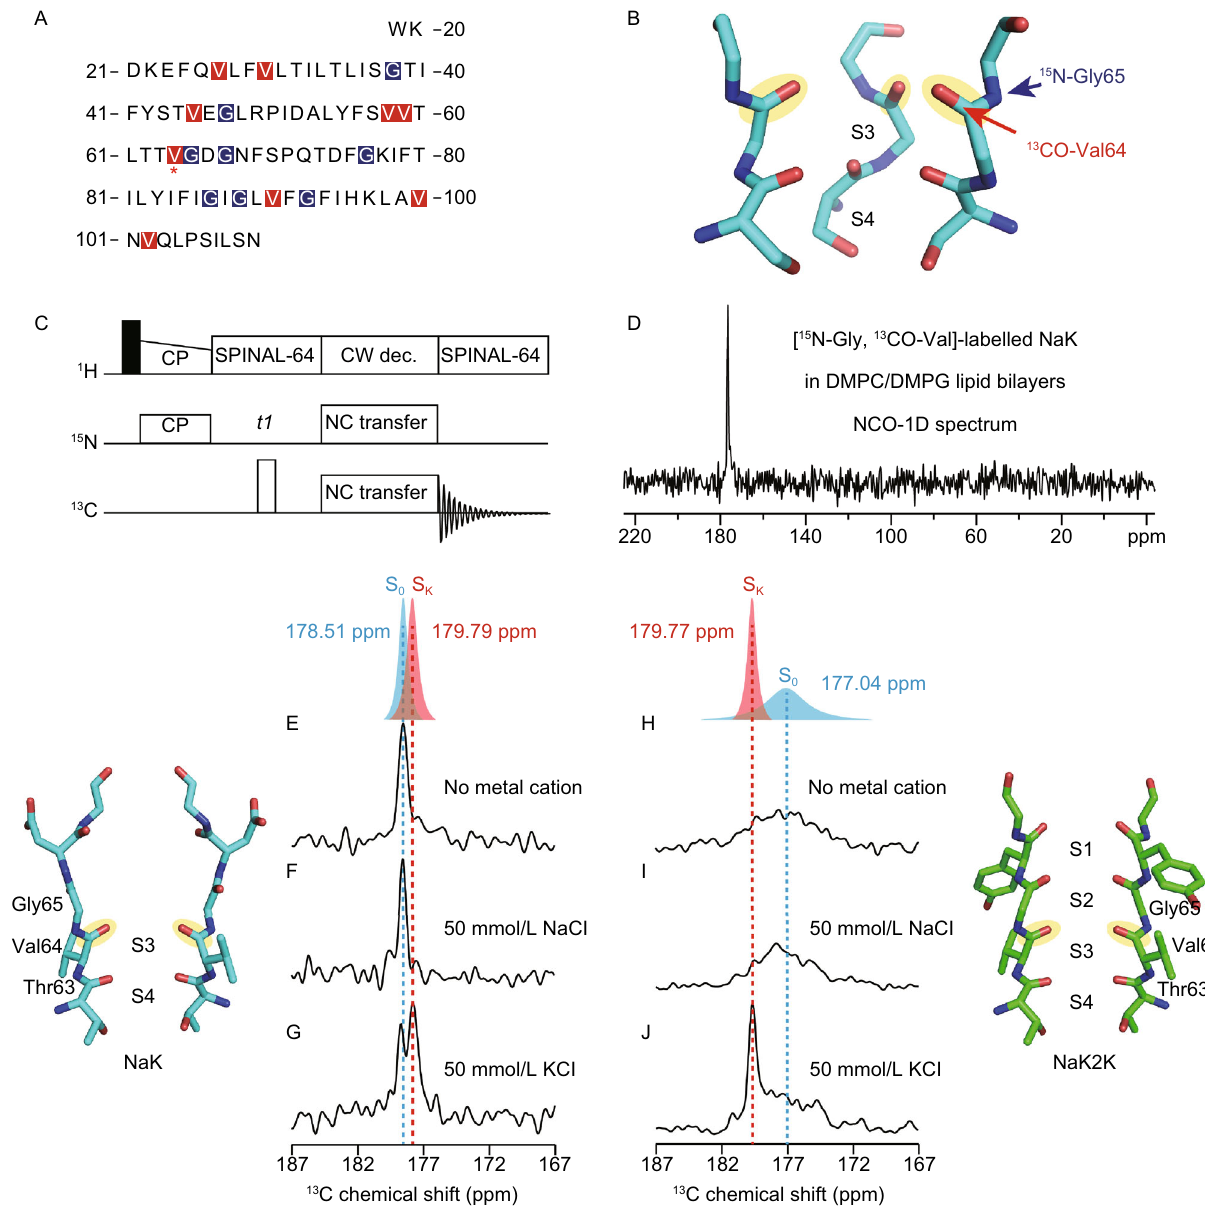
Figure 1. Site-speci fi c isotope labelling strategy and ssNMR analysis of 13C(O)-Val64 resonances at different cation conditions . (A) Amino acid sequence of the NaK channel. Val64 was marked with asterisk. (B) The carbonyl groups of Val64 were shaded in yellow. The front subunit was removed for clarity. (C) Pulse sequence of NCO DCP experiments. Open and fi lled bars represent 180° and 90° pulse, respectively. (D) One-dimensional 13 C-NCO spectrum of [ 15 N-Gly, 13 CO-Val]-labelled NaK in DMPC/ DMPG lipid bilayers. [ 15 N-Gly, 13 CO-Val]-labelled NaK in buffer without any metal cation (E), in presence of 50 mmol/L NaCl (F) or 50 mmol/L KCl (G). [ 15 N-Gly, 13 CO-Val]-labelled NaK2K in buffer without any metal cation (H), in presence of 50 mmol/L NaCl (I) or 50 mmol/L KCl (J). The carbonyl groups of Val64 were shaded in yellow on the structure of NaK and NaK2K selectivity fi